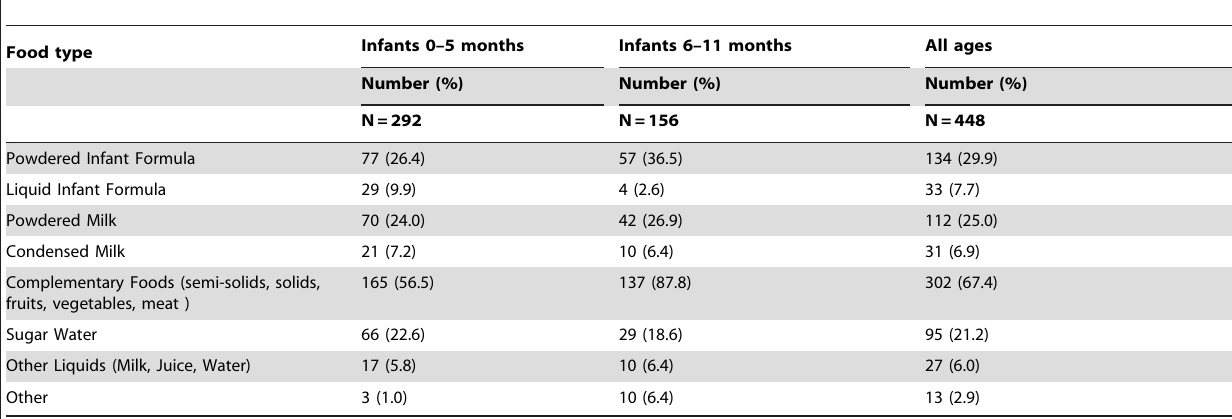
Table 3. Results of 24 Hour Recall of Types of Food Consumed by Non-exclusively Breastfed Infants Admitted into the RUIF Program, April–June 2010*.